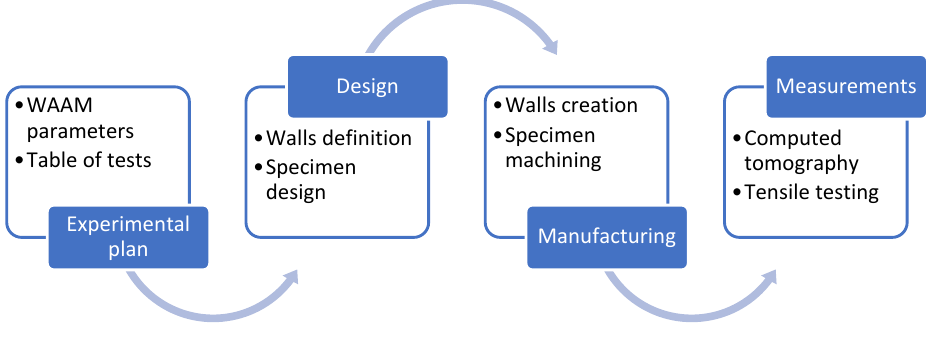
Figure 2. Research methodology.